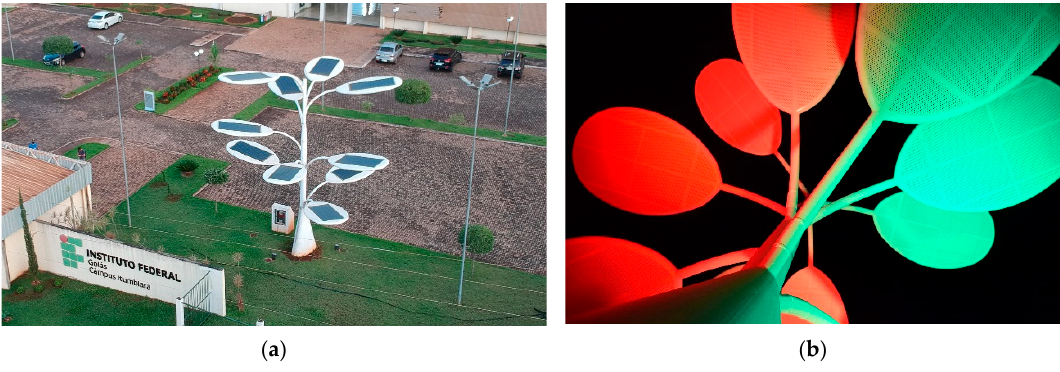
Figure 8. ( a ) Solar Tree; ( b ) Solar Tree with LED Lighting.